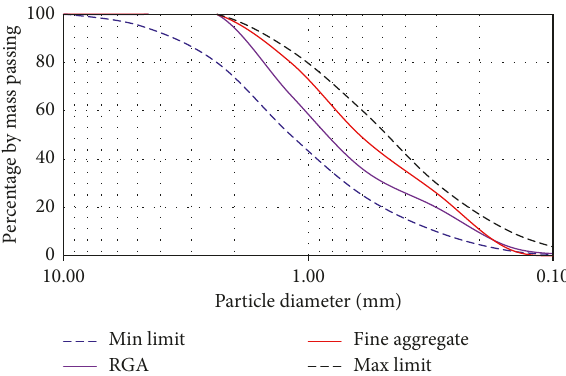
Figure 1: Particle size distribution of fine aggregate and RGA.